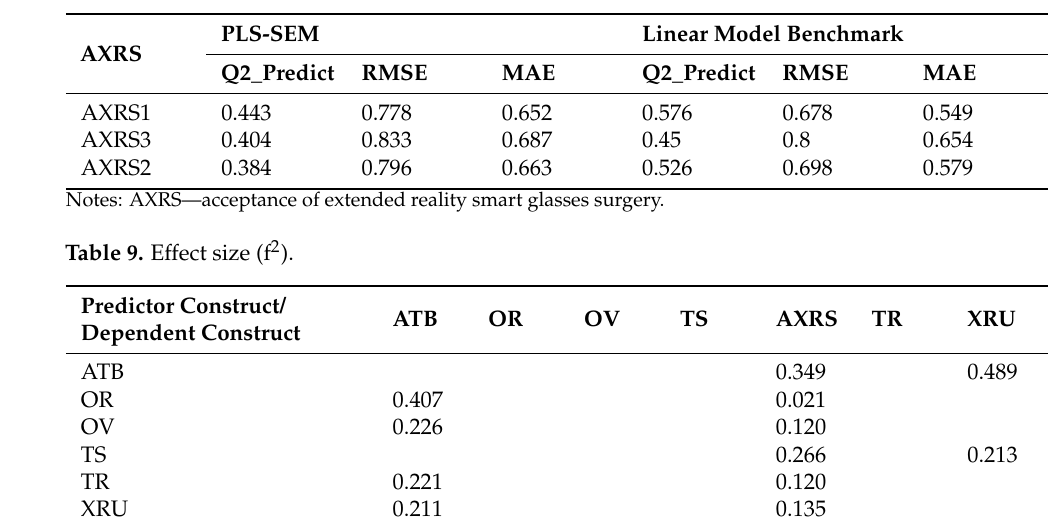
Figure 3. Result of hypotheses testing. * Significant at 5% level, p < 0.05. ** Significant at 1% level, p < 0.01. *** Significant at 0.1% level. Table 8. PLS prediction results.